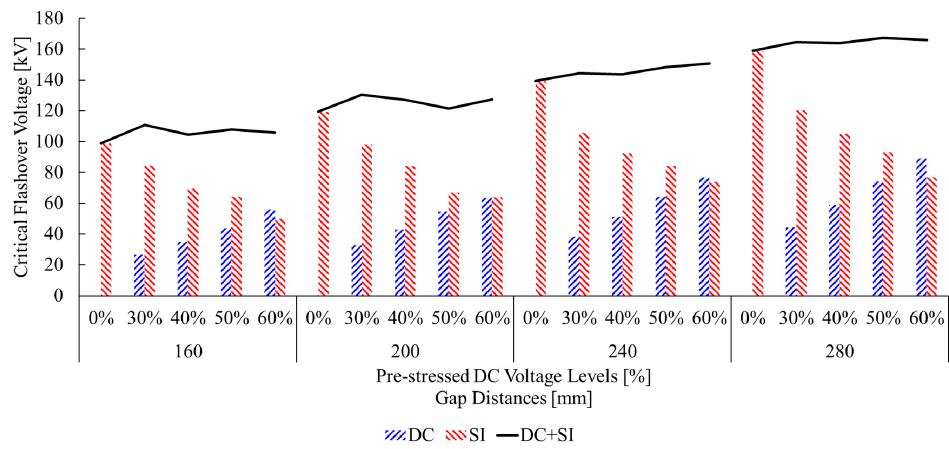
Figure 10. The experiment results of positive DC superimposed positive switching impulse for R12.5.